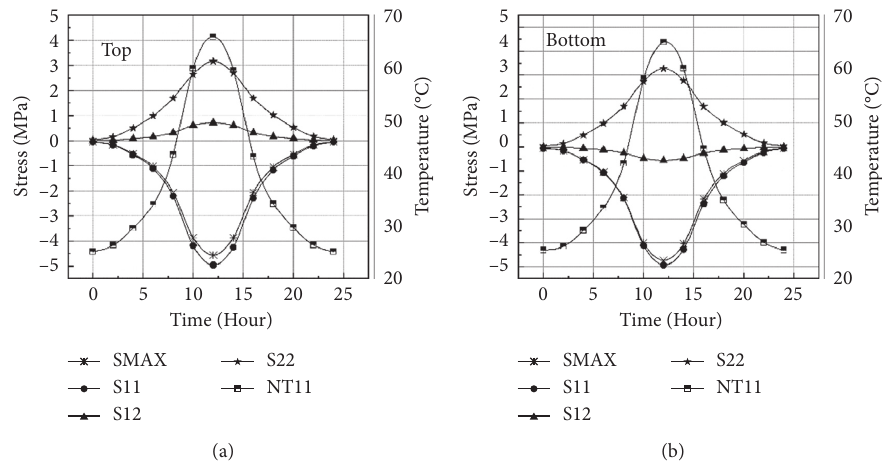
Figure 10: Time-history response curve of stresses above void area in the condition of after polymer grouting in the summer: (a) slab top and (b) slab bottom.